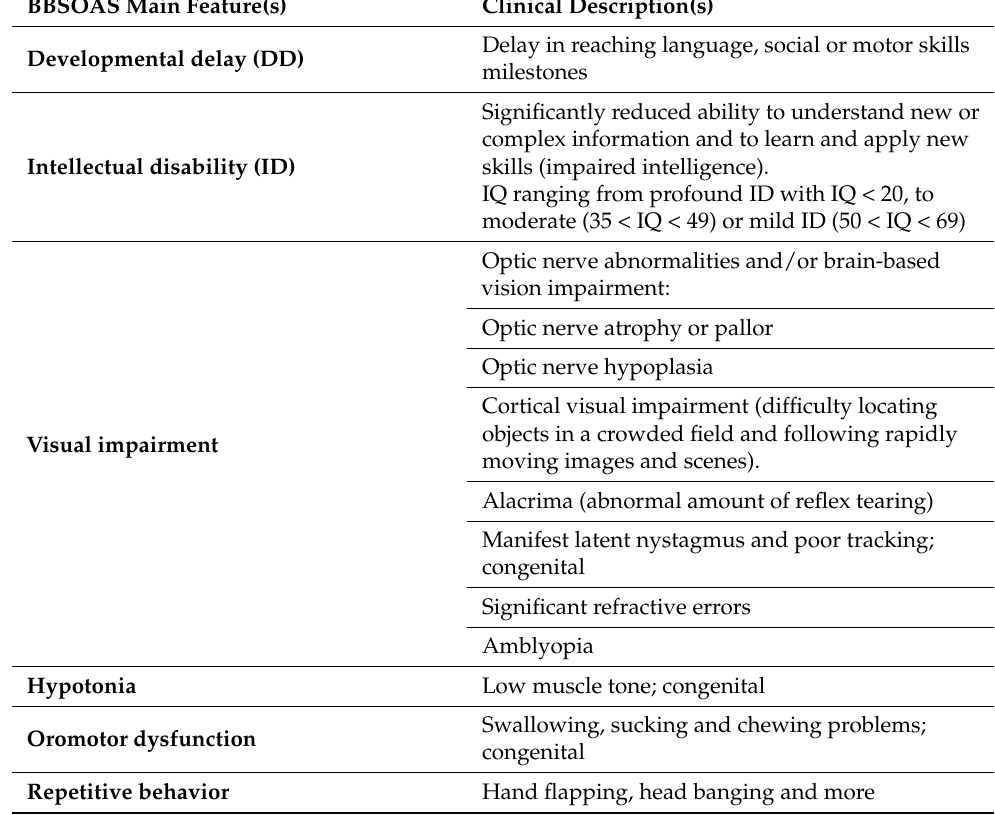
Table 2. List of BBSOAS main features . Table resuming the main clinical features of BBSOAS patients with NR2F1 haploinsufficiency; some of them are often present at birth (congenital), including hypotonia, nystagmus and oromotor dysfunction. The clinical features of BBSOAS are variable, and not every individual necessarily manifests all features. Further, the severity of the condition varies from one individual to the next. Abbreviations: ASD, autism spectrum disorder; ID, intellectual disability; IQ, intelligence quotient; MRI, magnetic resonance